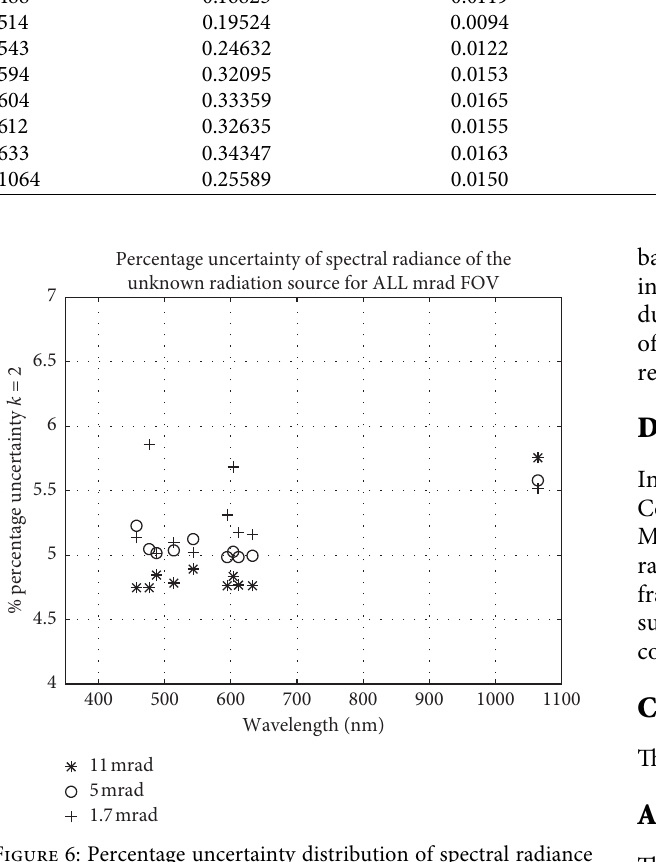
Table 5: k � 2 expanded standard uncertainty for 11mrad FOV in terms of both GUM and GUM Supplement-1. GUM Monte Carlo Wavelength calculationsCalculated radiance